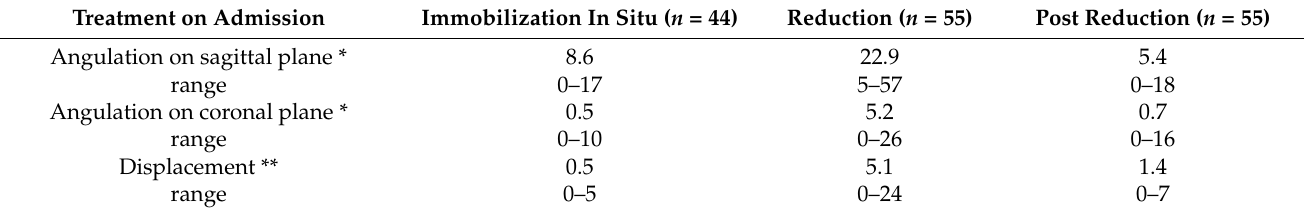
Table 4. Fracture position during primary care.